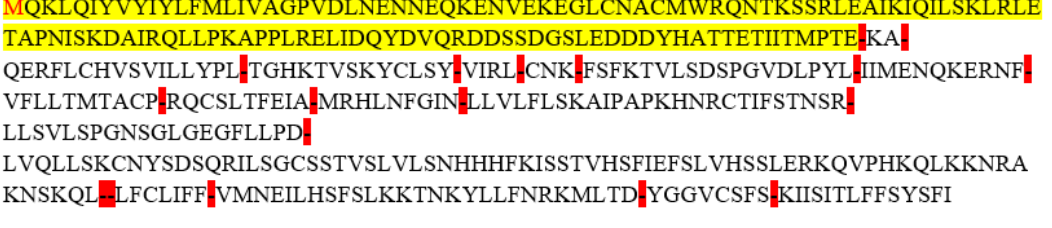
Figure 1. Expected amino acid sequences based on HSF results. ( A ) Simulation of retention of 793 bps in intron 1 due to the creation of an alternative donor splice site when the TAATAA allele belonging to 5var58464910 is present; ( B ) Simulation of retention of 871 bps in intron 1 due to the creation of an alternative acceptor splice site when the C allele belonging to 5var58464775 is present.